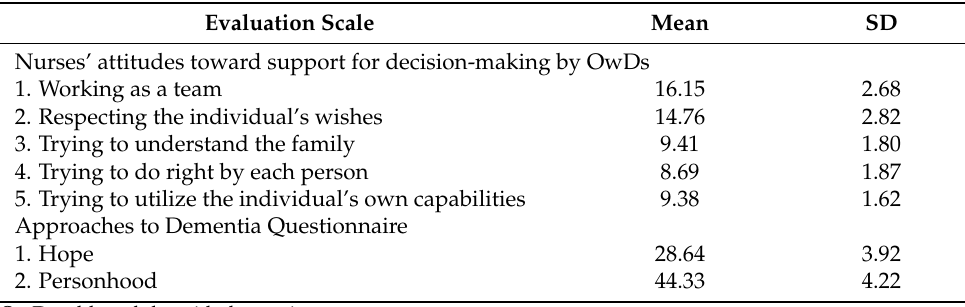
Table 2. Means and standard deviations (SD) of evaluation